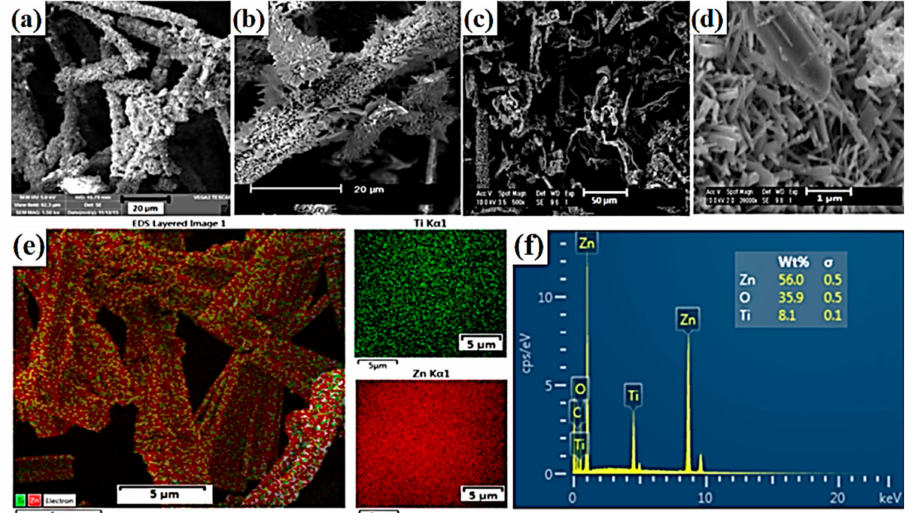
Figure 13. Images of TiO 2 -ZnO oxide materials: ( a , b ) SEM for samples before calcination; ( c , d ) SEM for calcined materials; ( e ) EDS mapping and ( f ) EDX spectrum (created based on [238] with permission from Springer).